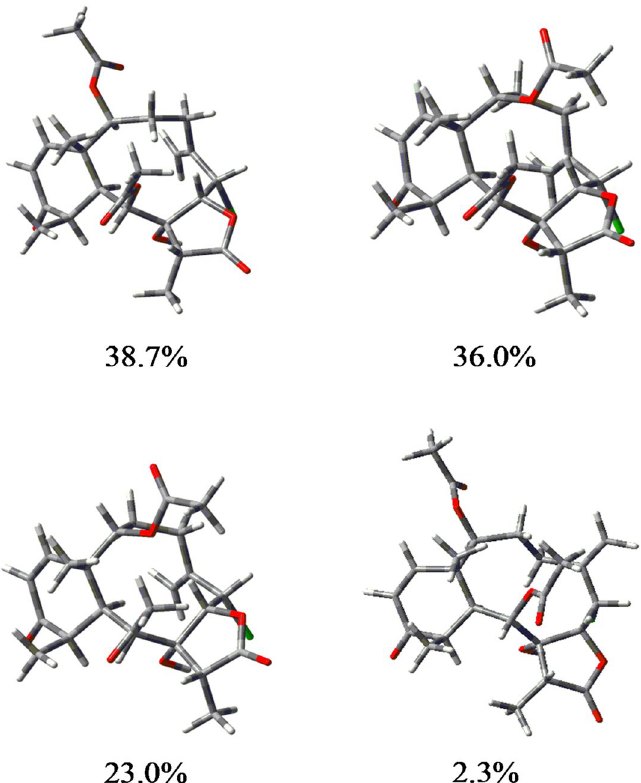
Figure 3. The four most stable conformers of briarane B-3 ( 1 ). Figure was created with Gaussview v